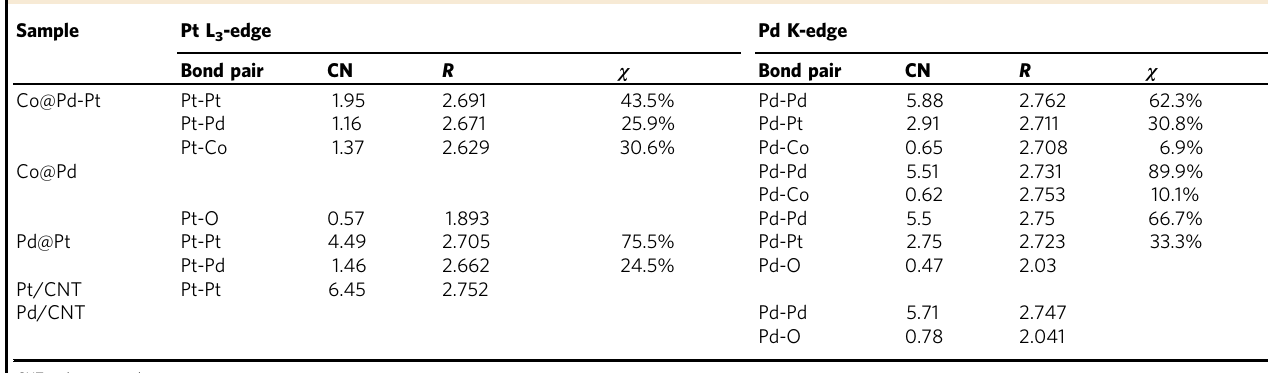
Table 1 Quantitative results of X-ray absorption spectroscopy model analysis at Pt L 3 -edge and Pd K-edge of Co@Pd-Pt/CNT nanocatalysts and control samples